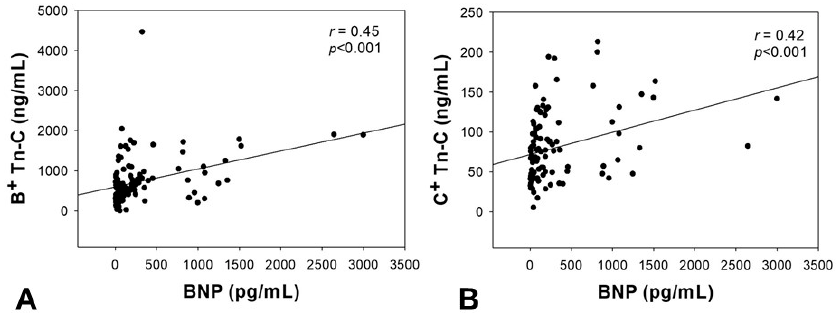
Figure 3. Correlation analyses between the serum concentration of B + ( A ) and C + ( B ) Tn-C and the brain natriuretic peptide (BNP). BNP = brain natriuretic peptide, Tn-C = tenascin C, p -value = level of significance, r -value = correlation coefficient.